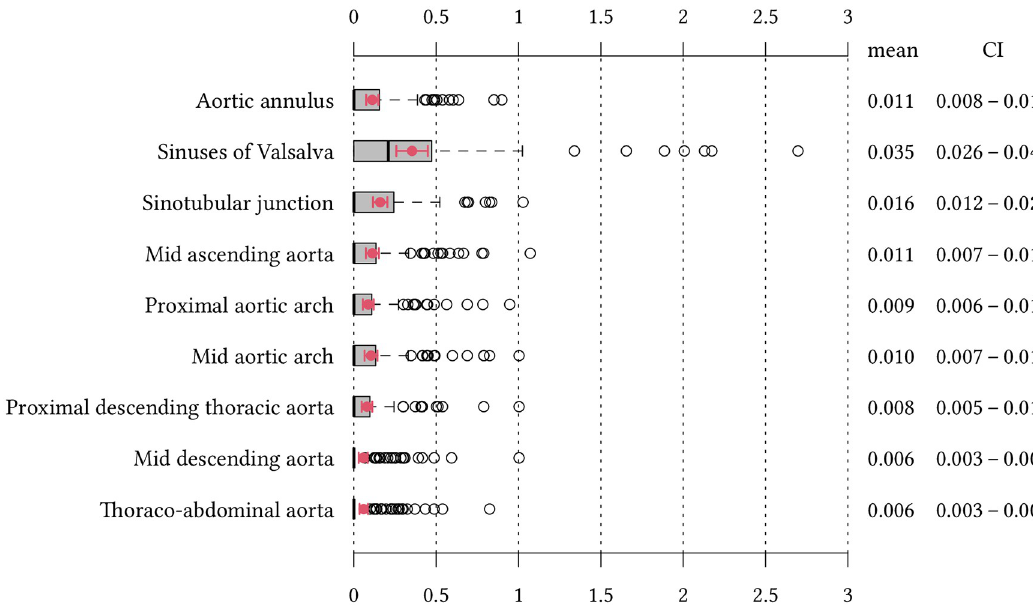
Fig 2. Boxplot analyses of naive growth rates at different aortic levels in 111 Marfan patients. Median naive (i.e., not adjusted) growth rates are indicated for each aortic level by thick vertical lines. The highest median growth rate was observed at the level of the sinuses of Valsalva. The right end of the box indicates the upper quartile and whiskers indicate the highest value within 1.5 IQR. Arithmetic naive mean and confidence intervals are displayed in red. Circles indicate outliers above the